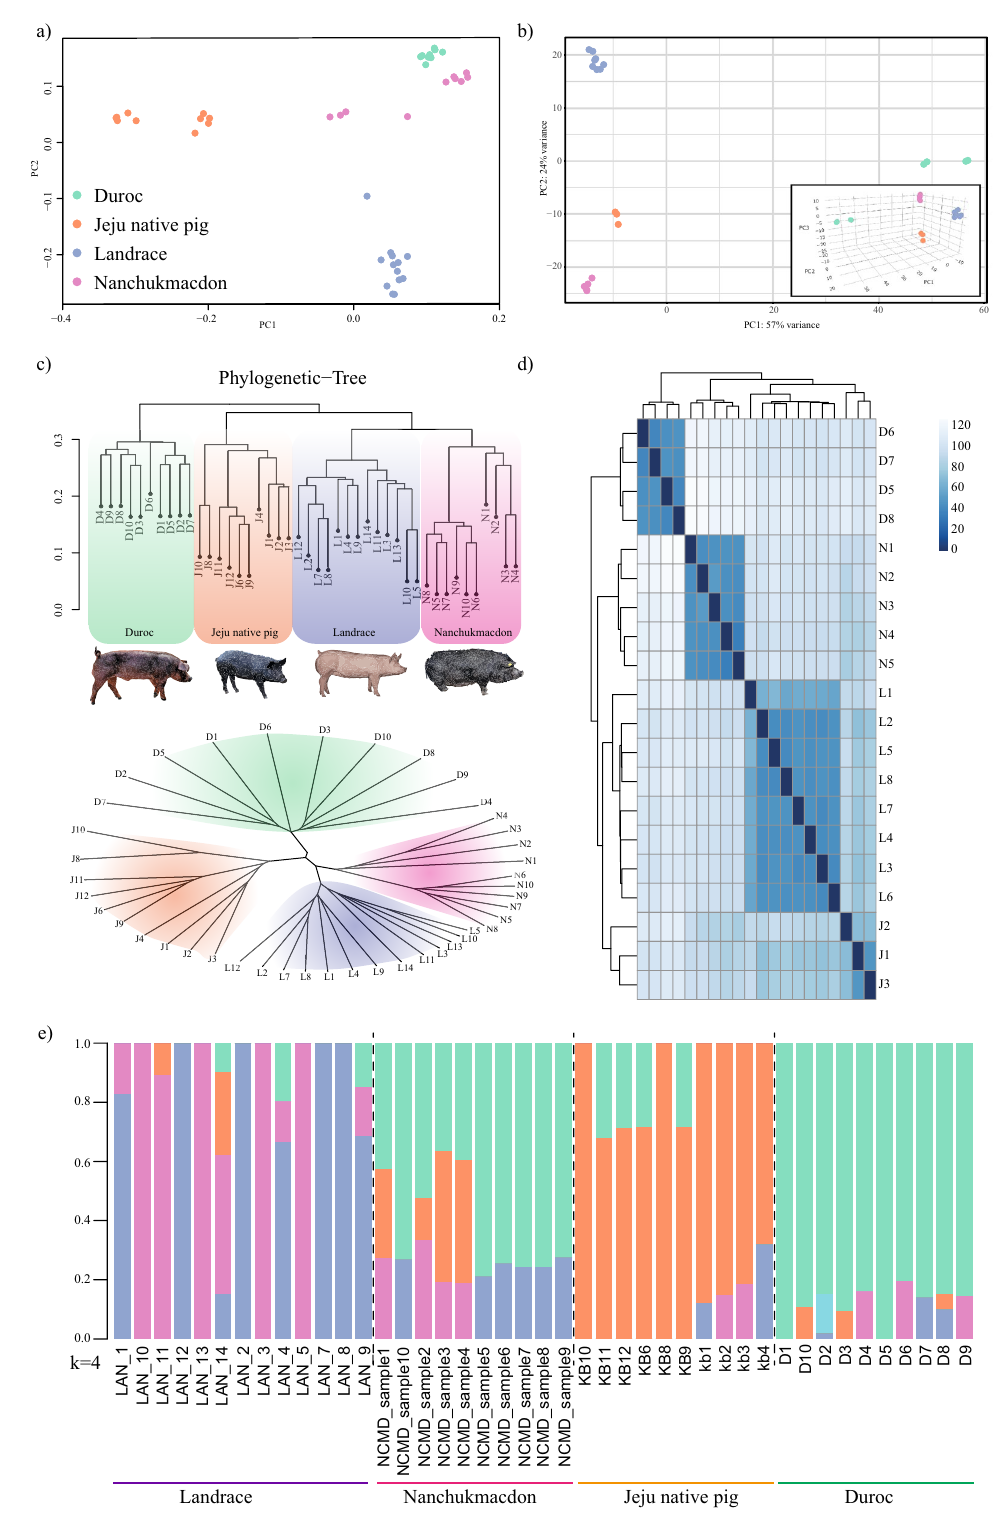
Figure 1. Population structure analyses for all pig individuals. ( a ) First and second principal components from a principal component analysis of all populations WGS data. ( b ) PCA for muscles RNA-seq data distinct the population group. ( c ) Rooted and un-rooted tree representation of related closeness amongst different pig breed. ( d ) Heat-map visualization of common DEGs: column represent DEGs from muscle and row represent assemble method from 20 pig samples. ( e ) Population structure plots for all pig populations at K =